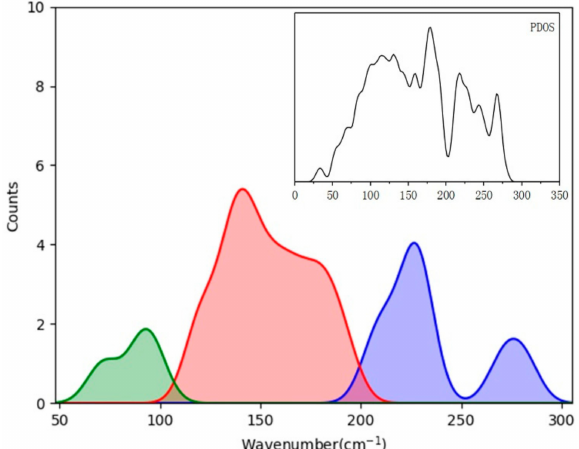
Figure 2. Top view of six normal modes in translational band (107, 206, and 285 cm − 1 ) and libration band (477, 913, and 936 cm − 1 ). Typical molecular vibrations are shown in gold.